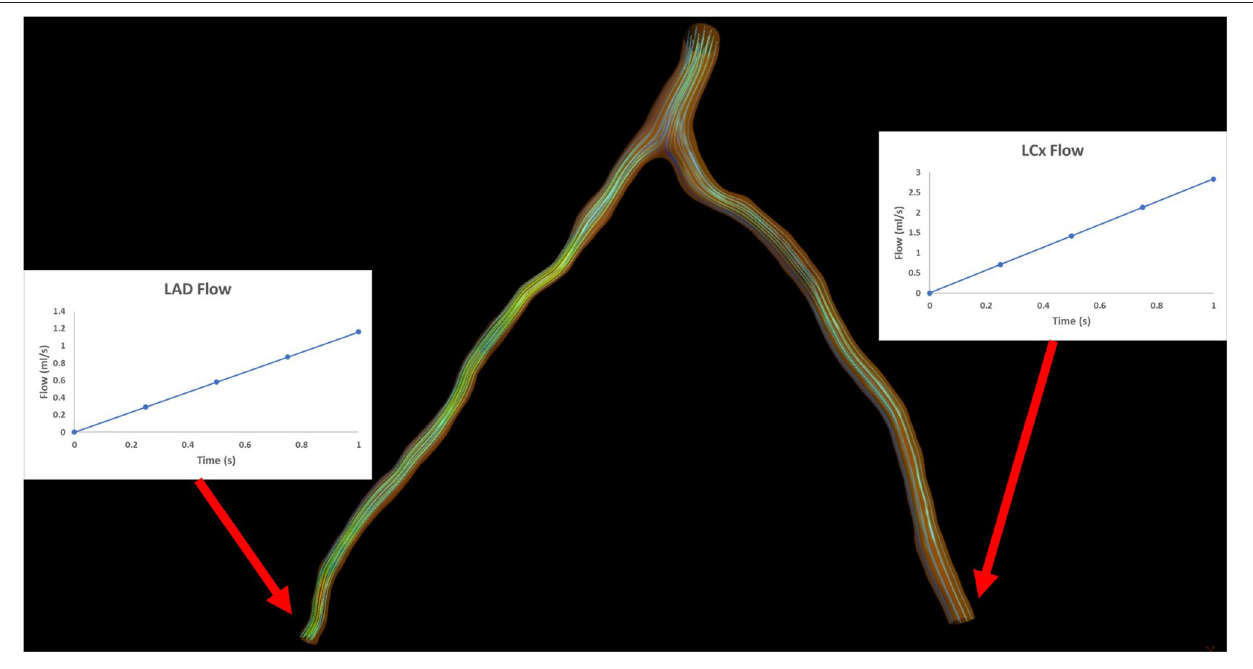
FIGURE 2 | Illustration depicting the outlet boundary conditions for an arterial bifurcation.